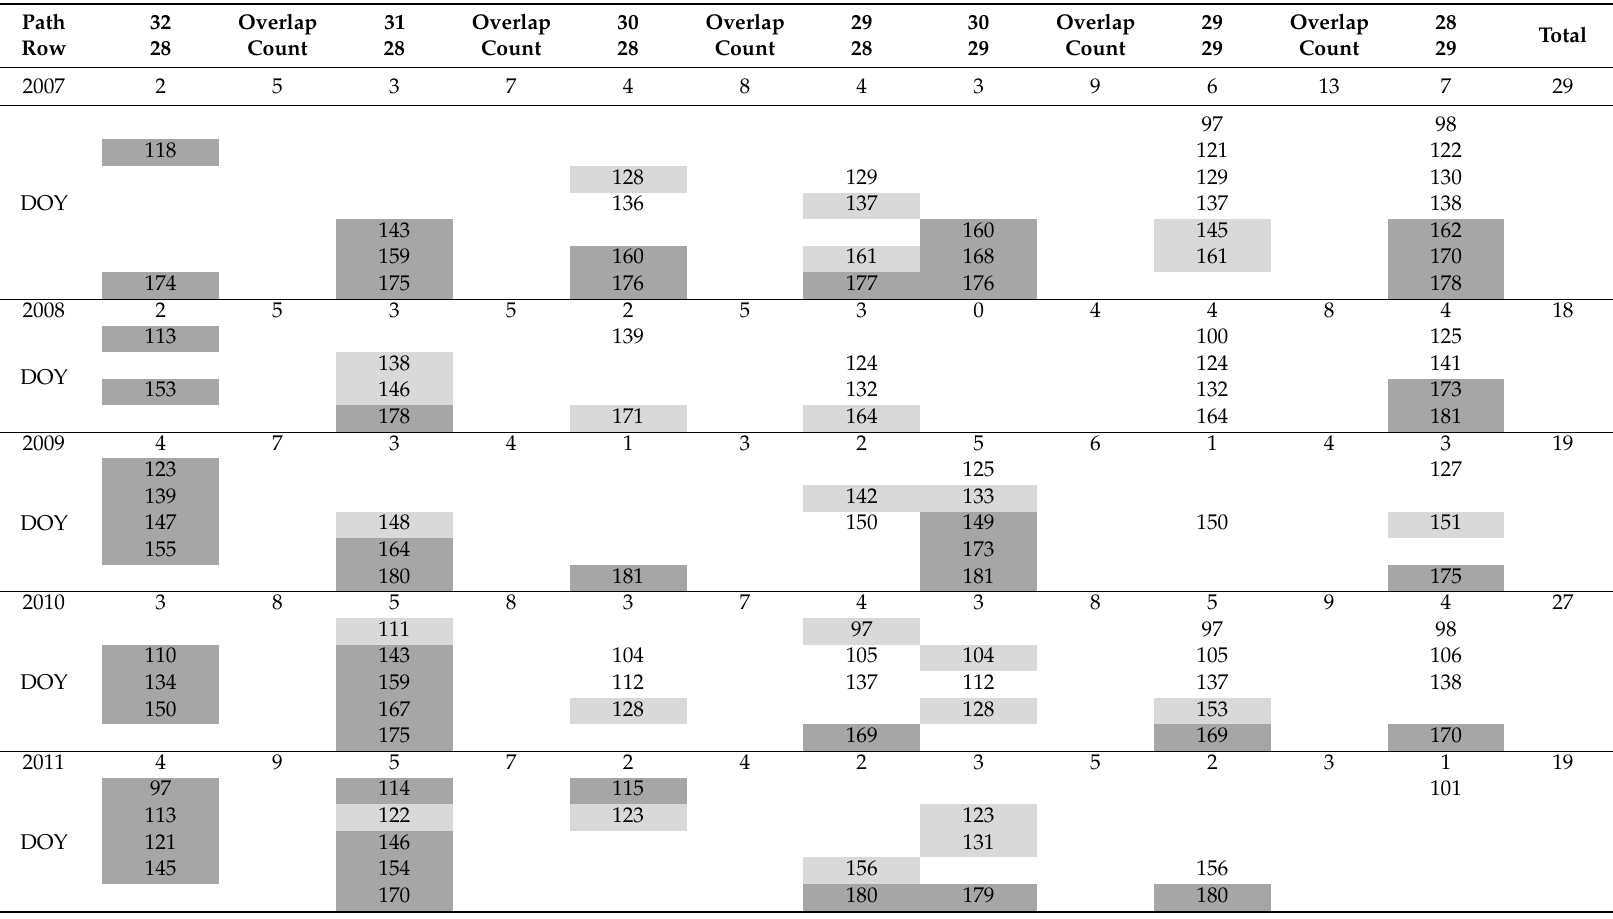
Table 2. Summary of satellite images and the accumulation in the east-west overlap occurrences and summary of image acquisition dates (day of year). Dark gray fill indicates where the image is more than 100% to 75% masked, Light gray fill indicates where the image is 75% to 50% masked, and non-filled cells are greater than 50% remaining for